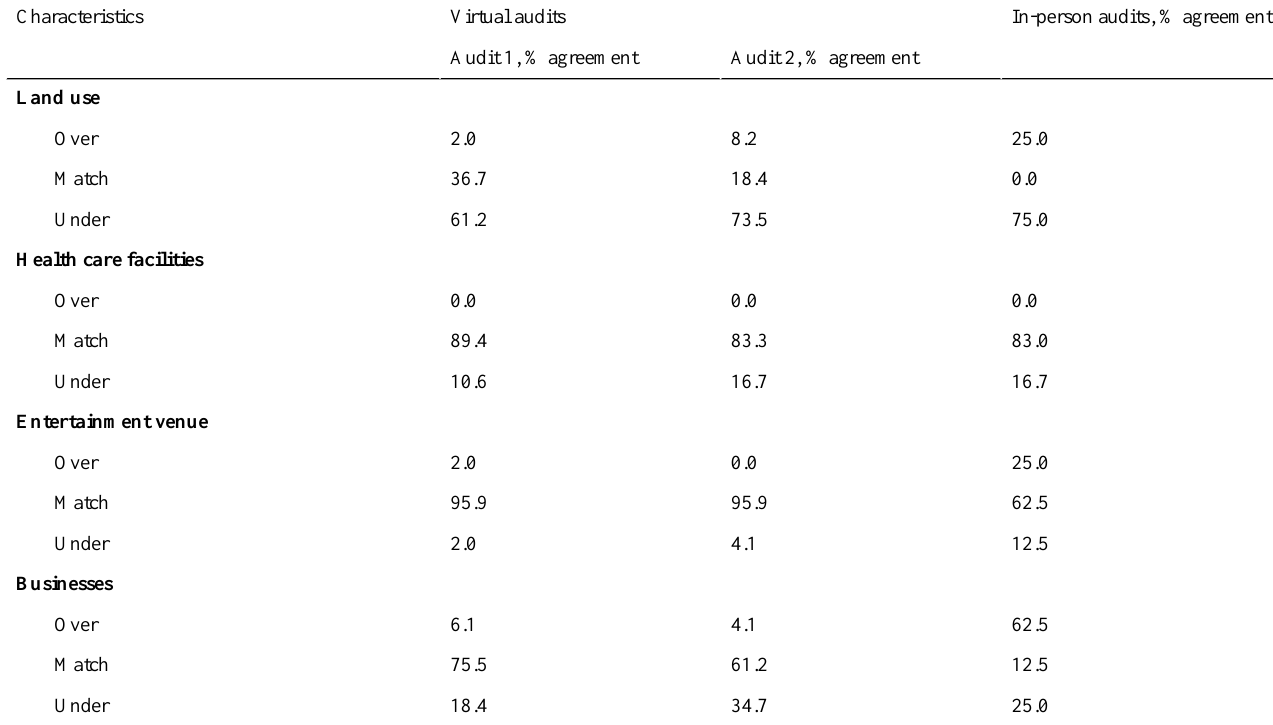
Table 2. Reliability of neighborhood characteristics collected in rural Kentucky using virtual and in-person audits versus the gold standard.